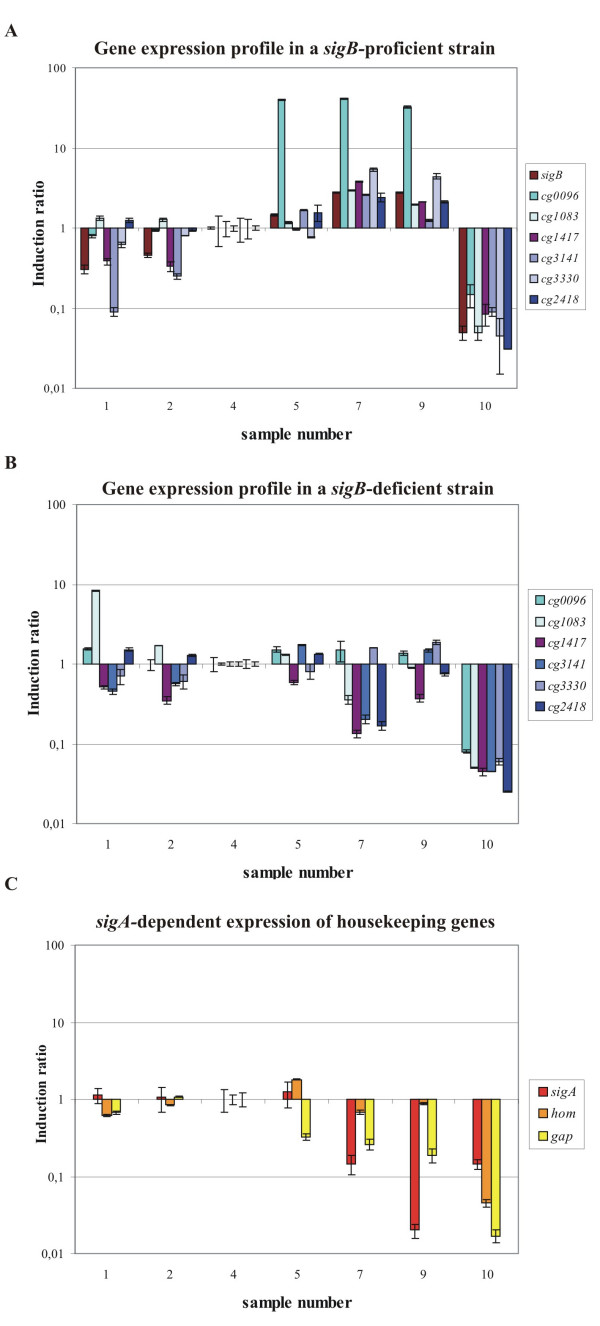
Real-time RT-PCR analysis of relative transcription levels of sigB, cg0096, cg1083, cg1417, cg3141, cg3330, cg2418, sigA, hom, and gap during growth. The sample numbers refer to the growth curves shown in Figure 1. Transcription levels were calculated relative to sample number 4 (early exponential phase). The diagrams show gene expression in the sigB-proficient strain C. glutamicum RES167 (A) and in the sigB-deficient strain C. glutamicum CL1 (B). Diagram (C) shows relative expression levels of known SigA-dependent genes of C. glutamicum RES167.